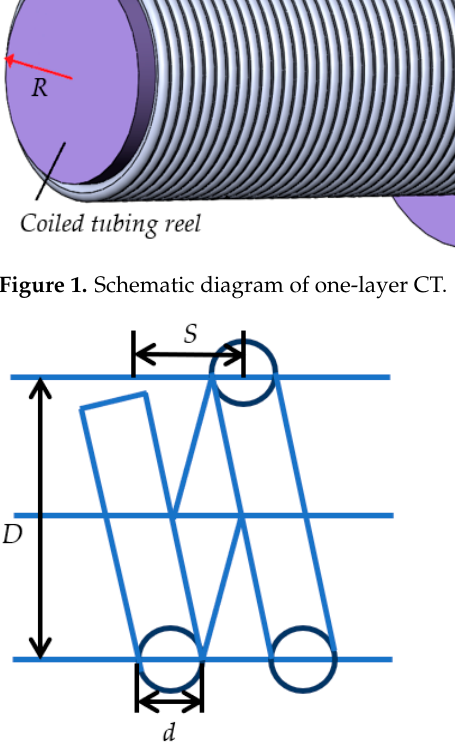
Figure 2. Geometric parameters of element helical segment. Table 1. Geometric dimensions of coils and